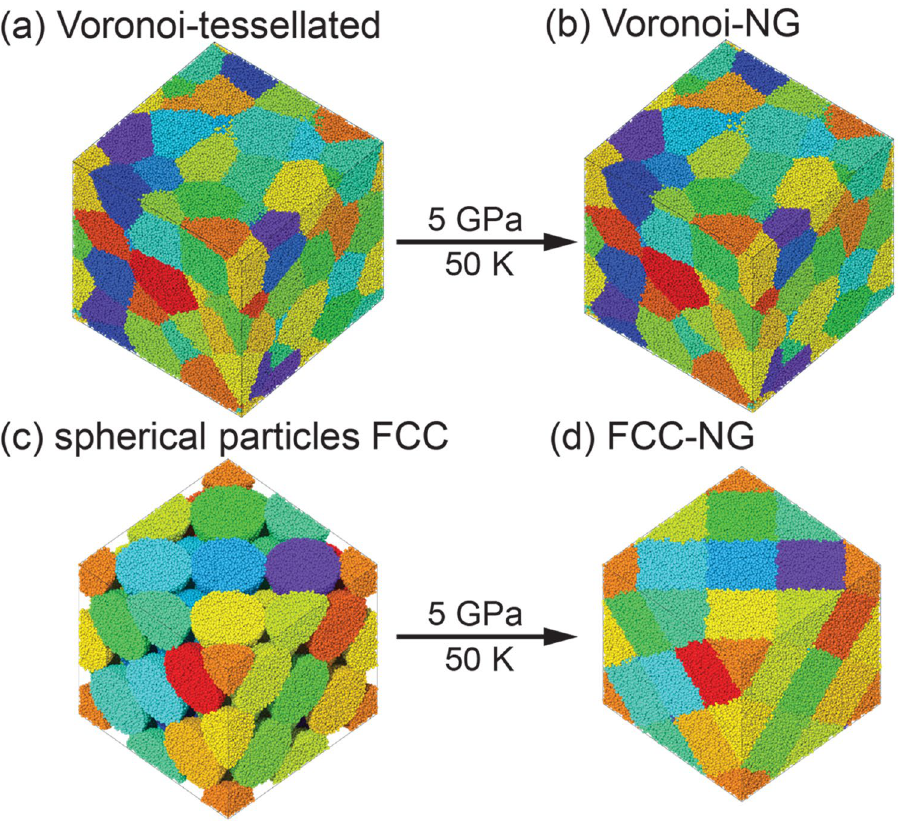
Figure 1. Illustrations of the nanoglass (NG) models generated by cold compression. ( a )–( b ) NG produced from Voronoi-tessellated microstructure. ( c )–( d ) NG produced from spherical particles arranged in a fcc structure. Colors indicate different nanoparticles. Images created with OVITO version 3.5.3, https:// www. ovito. org.